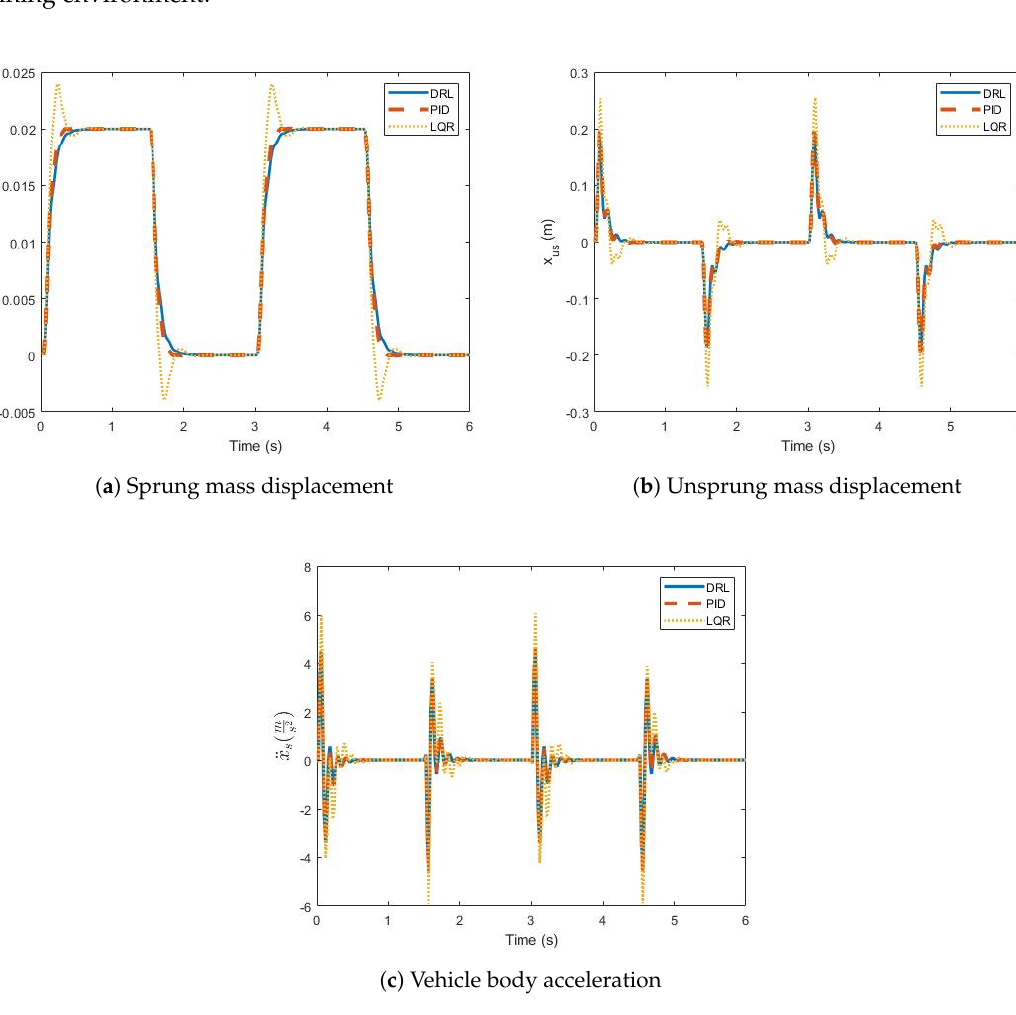
Figure 7. Scenario 1